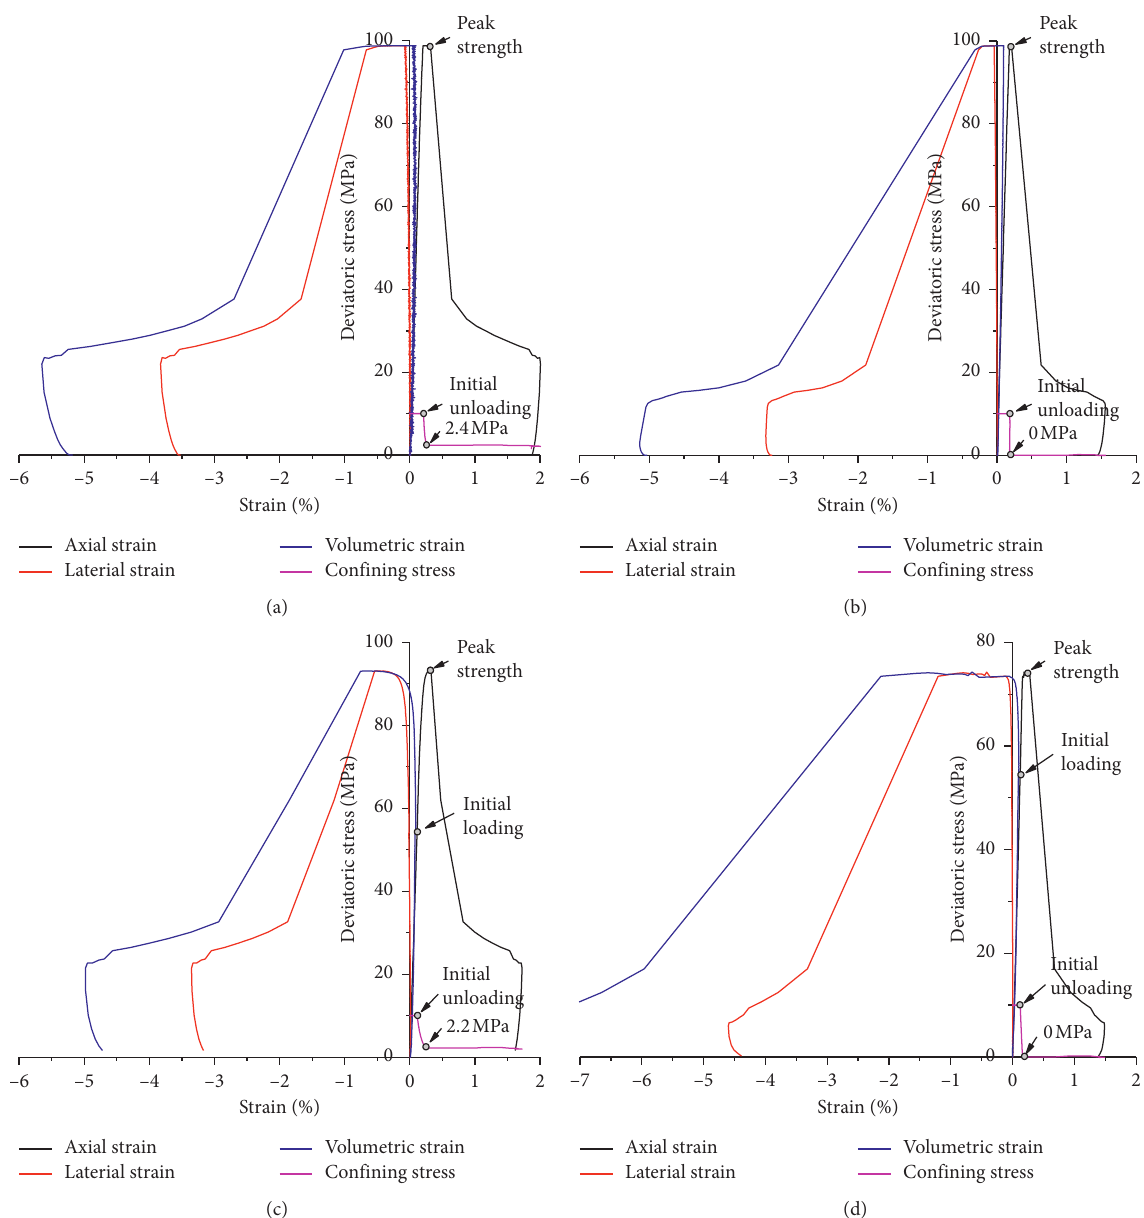
Figure 4: Stress-strain curves in complex loading-unloading stress tests (confining pressure: 10 MPa): (a) sample 10; (b) sample 11; (c) sample 12; and (d) sample